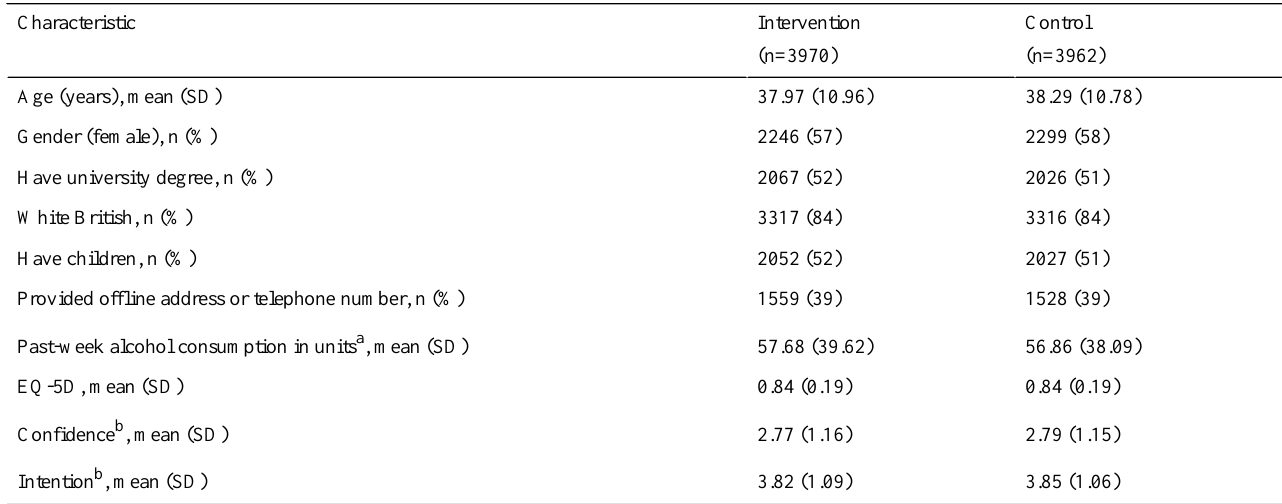
Table 1. Baseline characteristics of the study population (N=7932).